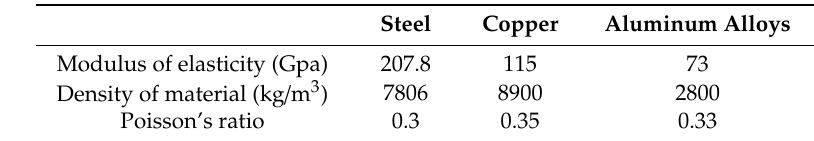
Table 6. Corresponding rotating shaft material parameters.